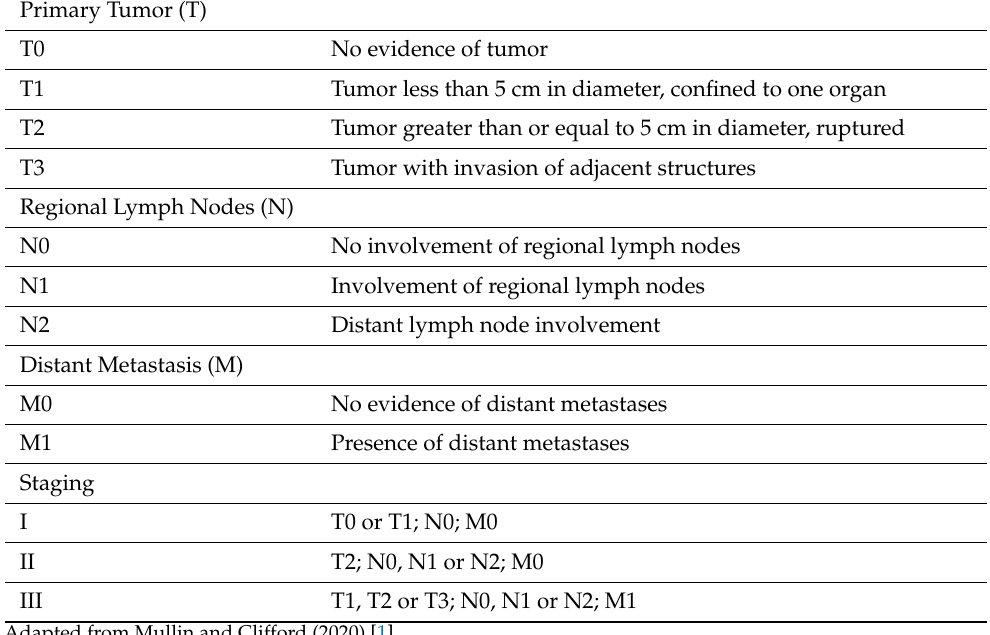
Table 4. Proposed clinical staging model for canine visceral HSAHSA.